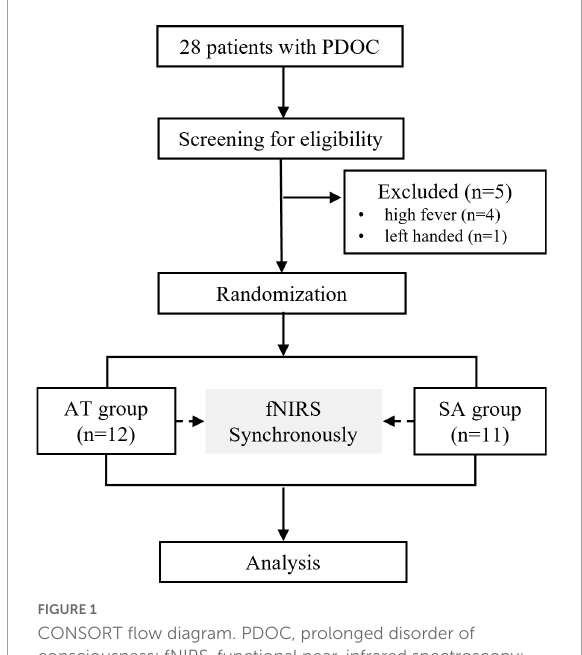
FIGURE1 CONSORT flow diagram. PDOC, prolonged disorder of consciousness; fNIRS, functional near-infrared spectroscopy; AT, acupuncture treatment; SA, sham acupuncture.